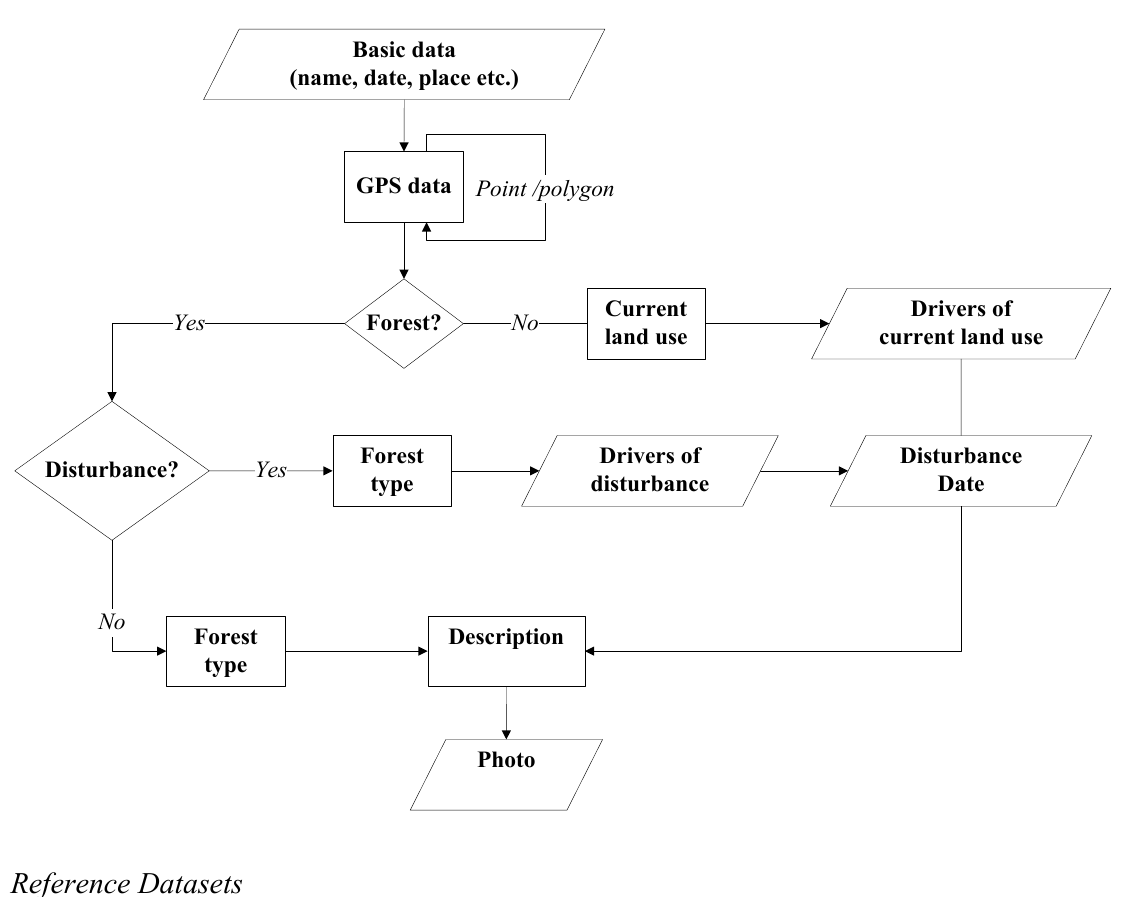
Figure 2. Decision-based data acquisition form for local experts; the questions that are posed in the forms depend on answers given to preceding questions; such a design ensures that the questions are relevant to the land cover change being